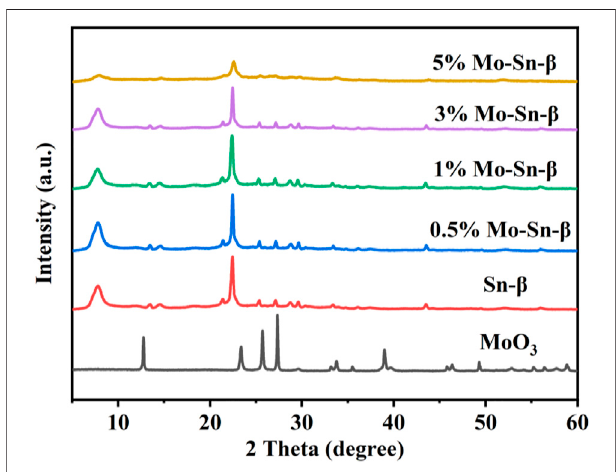
FIGURE 1 | XRD patterns of Mo-modi fi ed Sn- β .